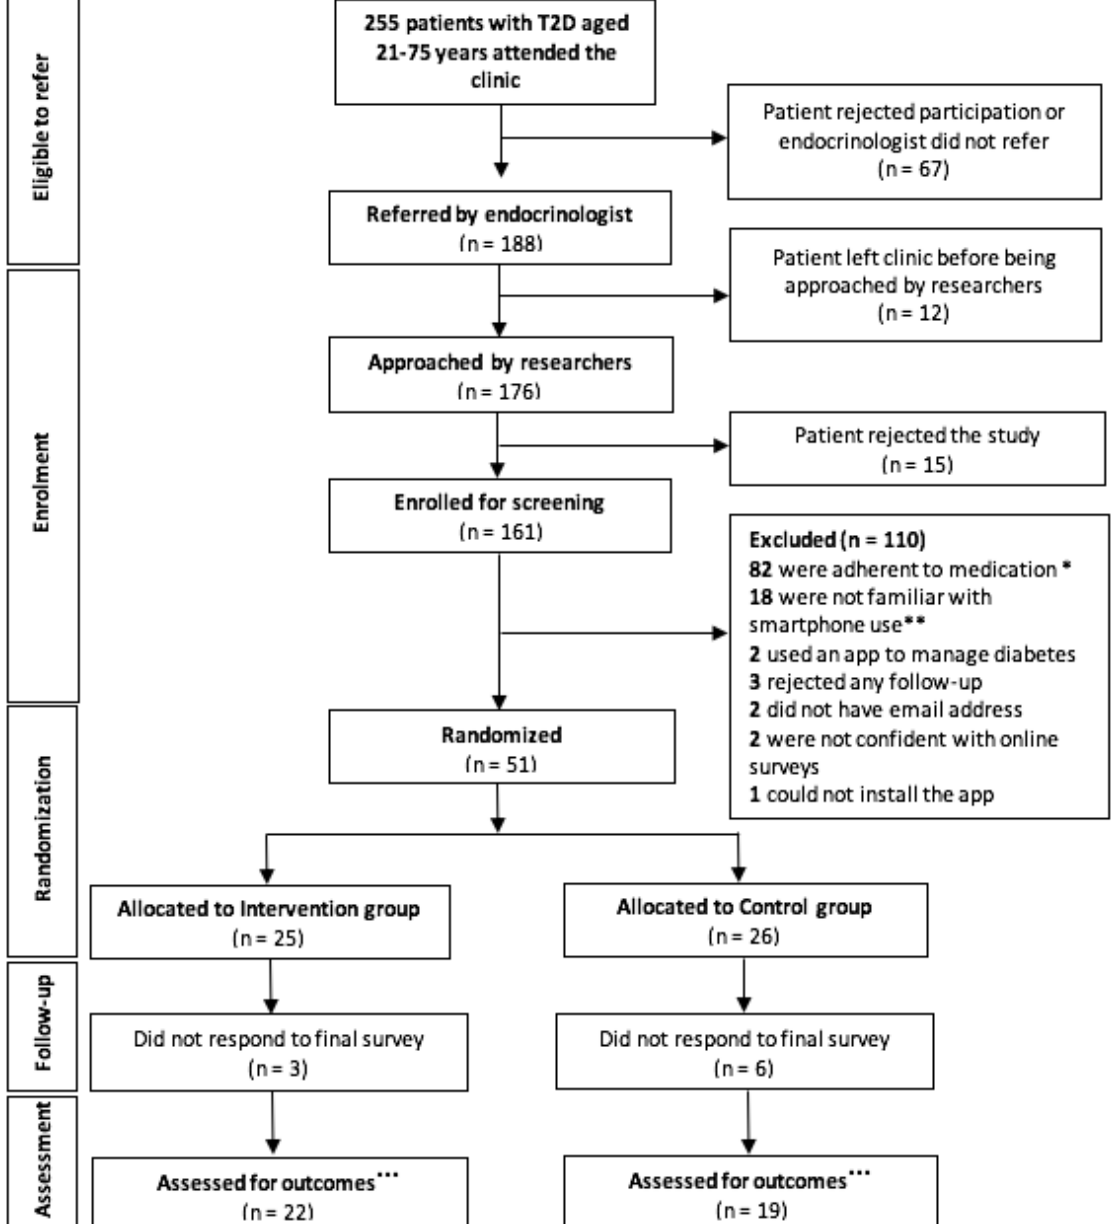
Figure 2. Diagram of participant flow. T2D: type 2 diabetes. *Participants were considered adherent if they answered “disagree/neutral” to the question, “I forget to take my medicines some of the time” or any option within 3 months to the question, “Have you taken a medicine more or less often than prescribed?” in the Adherence Starts with Knowledge-12 questionnaire. **Patients who were not confident of using a new app. ***Three intervention group participants stopped using the app; two control group participants started using an app to manage diabetes during the follow-up period.